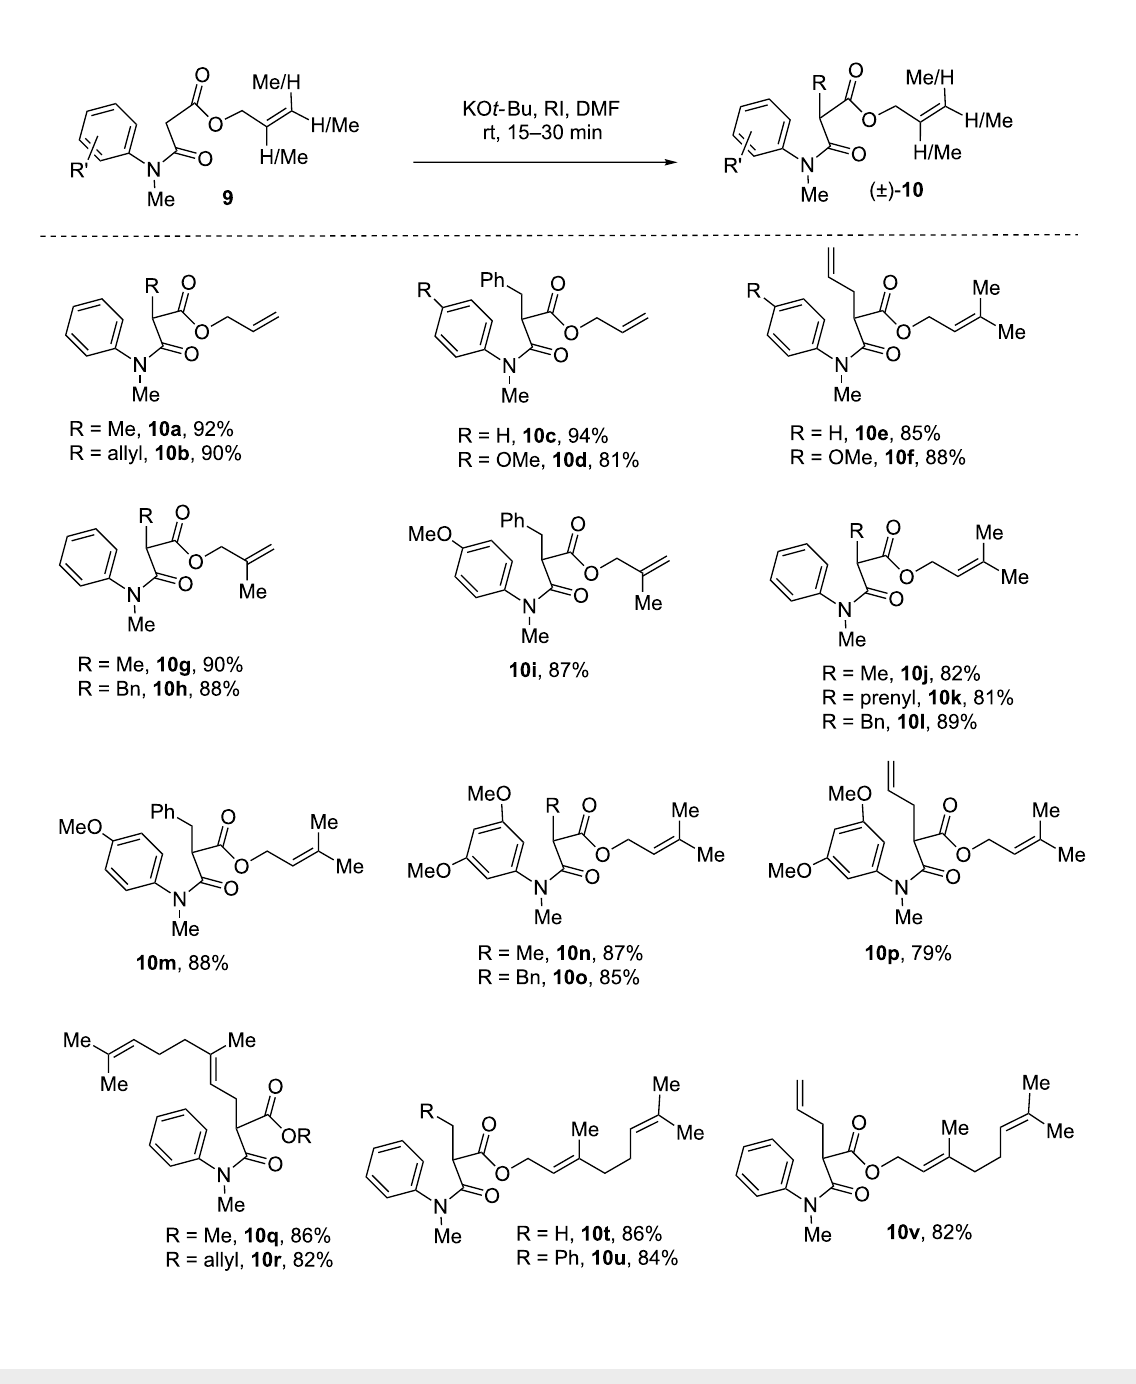
Figure 4: C-Alkylation of anilides using KO t -Bu.